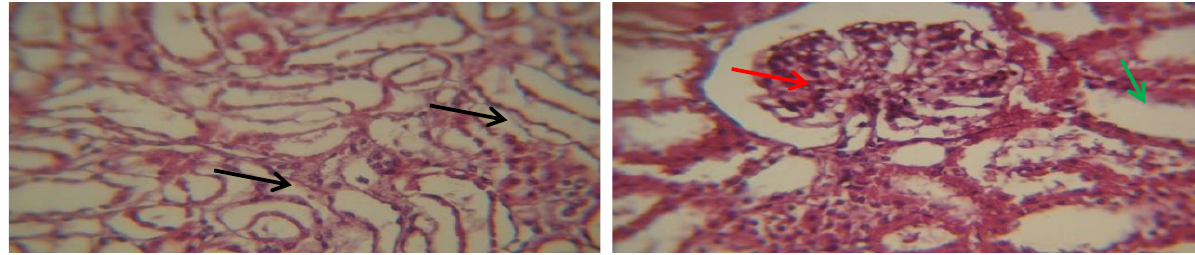
Figure 4. Section of kidney in ZNO group shows normal renal cortex with normal glomerulus (red arrow) and renal tubules (green arrow) and normal medulla with normal renal tubules (black arrow). H&E 100× and 500×